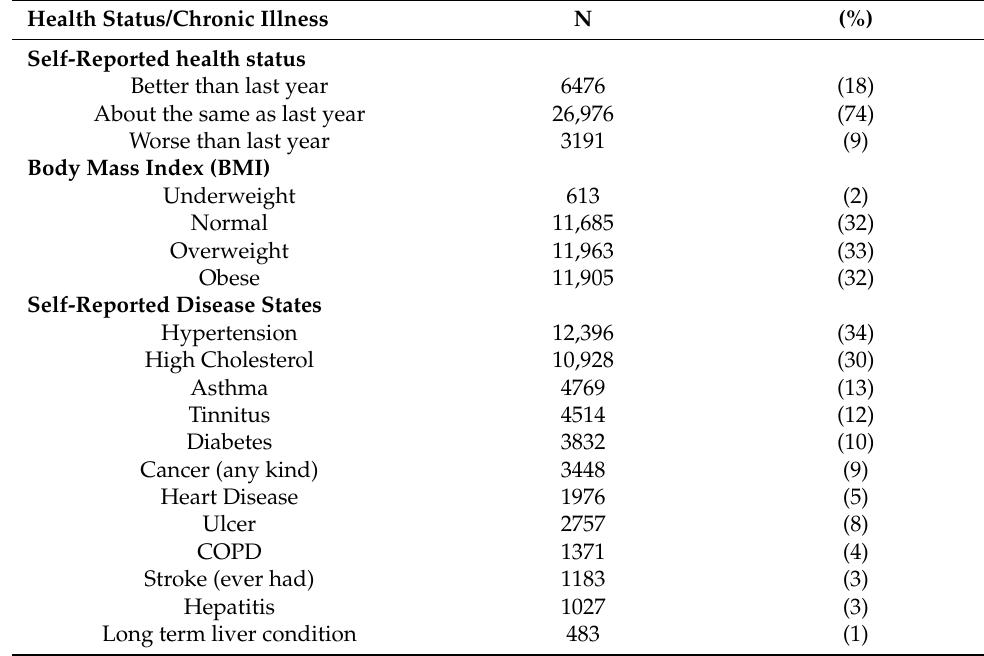
Table 2. Self-reported health status and disease states: all NHIS respondents (2014).